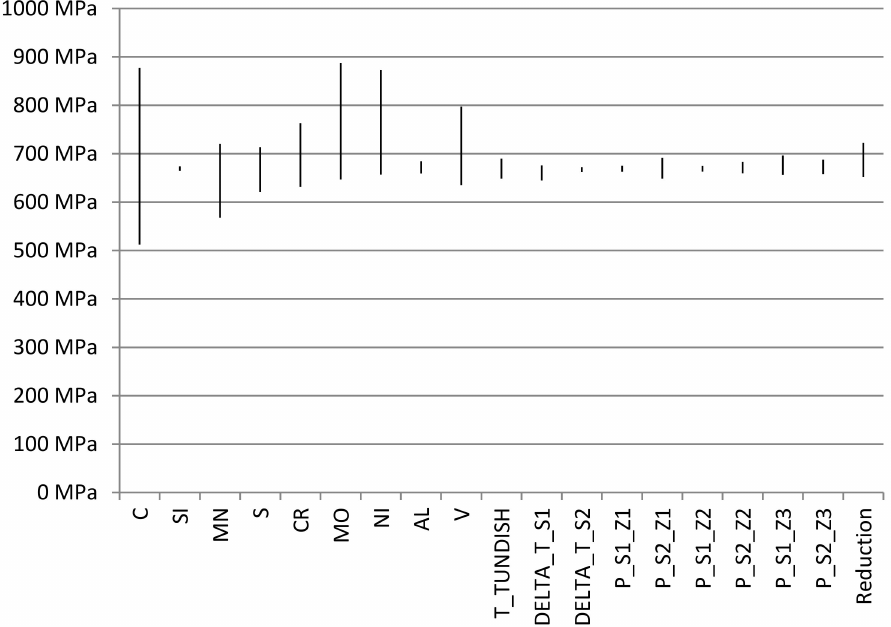
Figure 1. Calculated influences of individual parameters on tensile strength using the Multiple Linear Regression